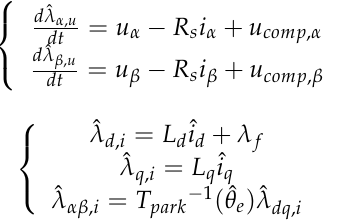
Figure 3. Structure of the PLL observer.